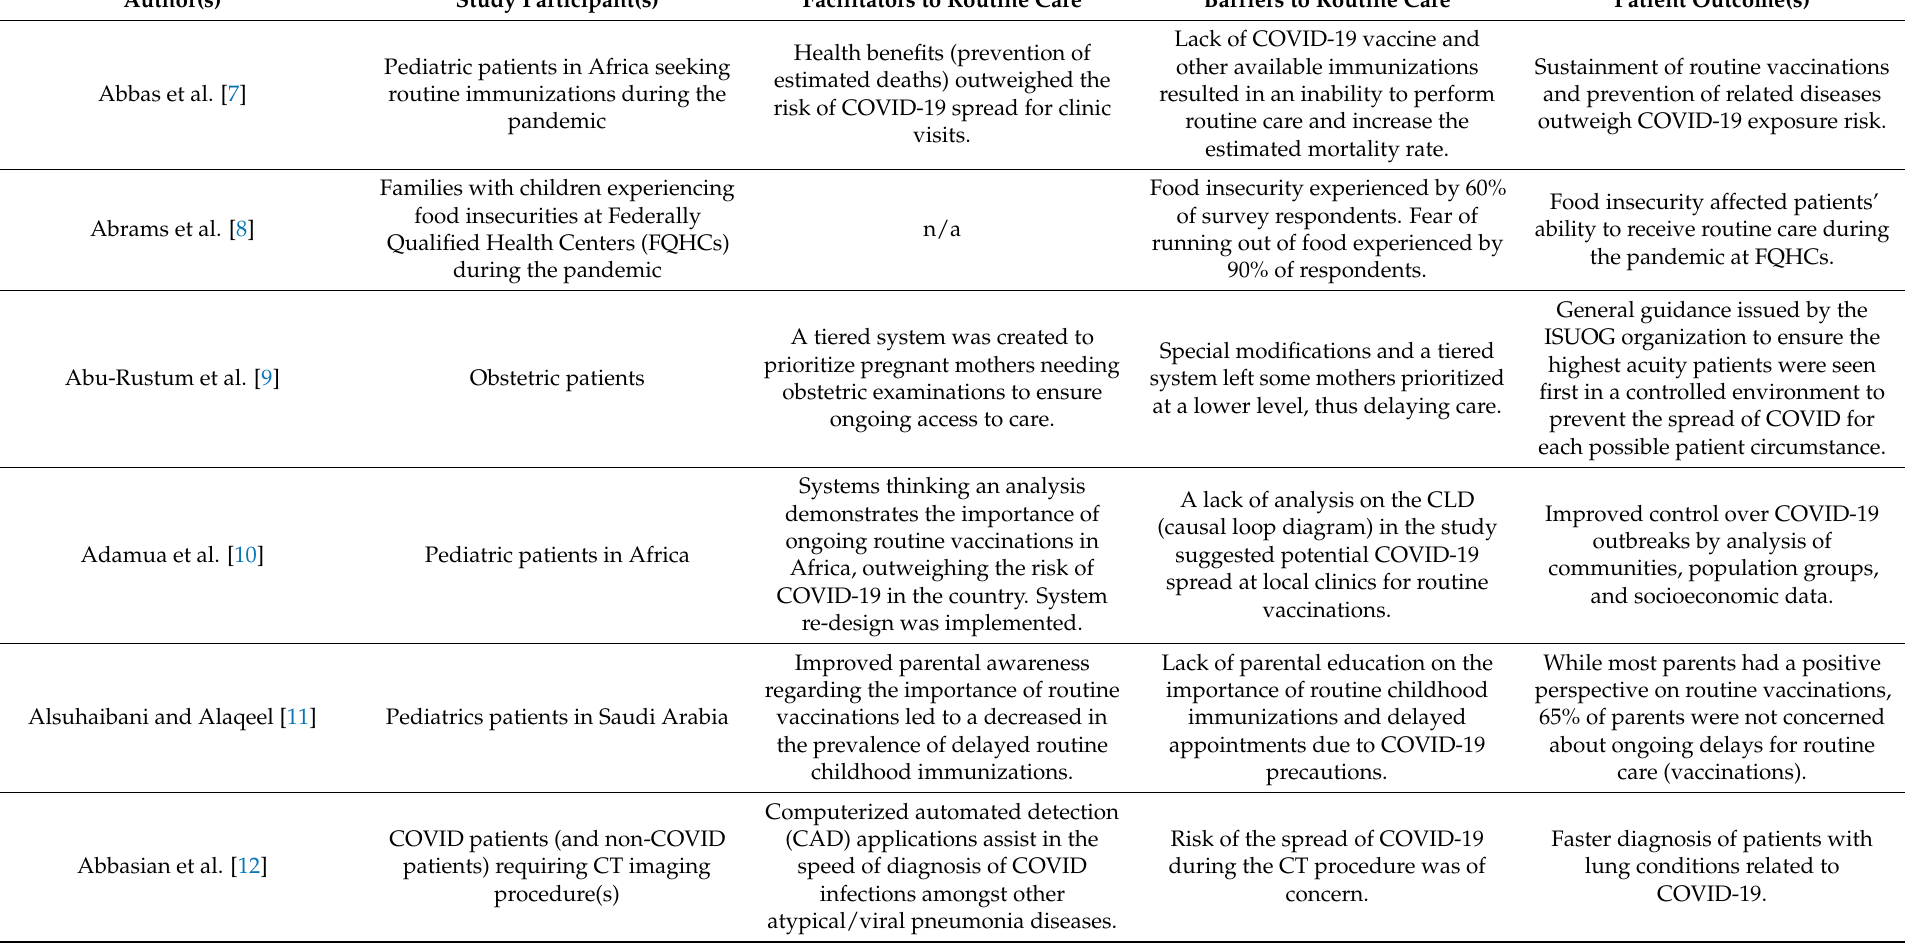
Table 1. Summary of Findings ( n =